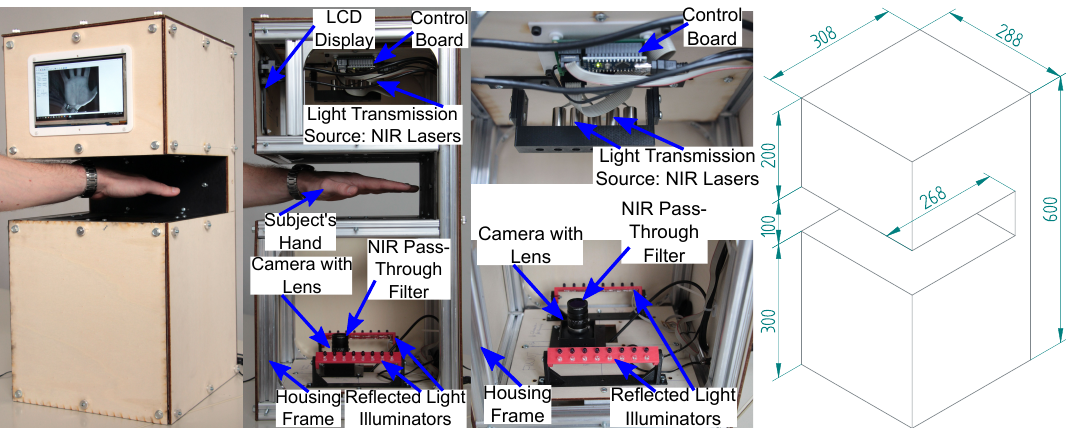
Figure 2. Contactless finger and hand vein capturing device, from left to right: device in use during acquisition, side view with annotated parts, top side view and bottom side detail view, housing including